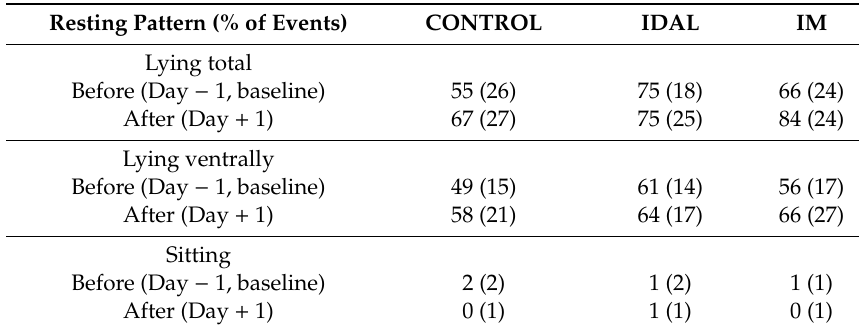
Table 4. Resting postures expressed as a median and interquartile range of occurrence in the CONTROL, IDAL and IM groups.